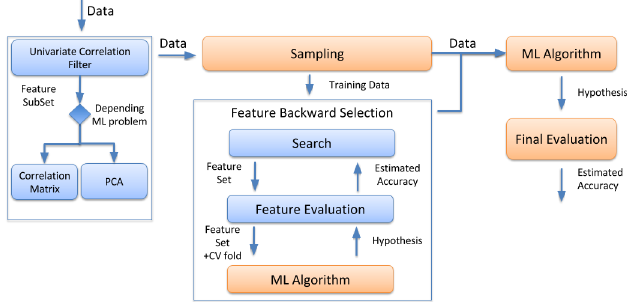
Fig 1. Proposed workflow for FS including a filtering step with univariate and/or multivariate approaches, followed by a wrapper approach (recursivefeature